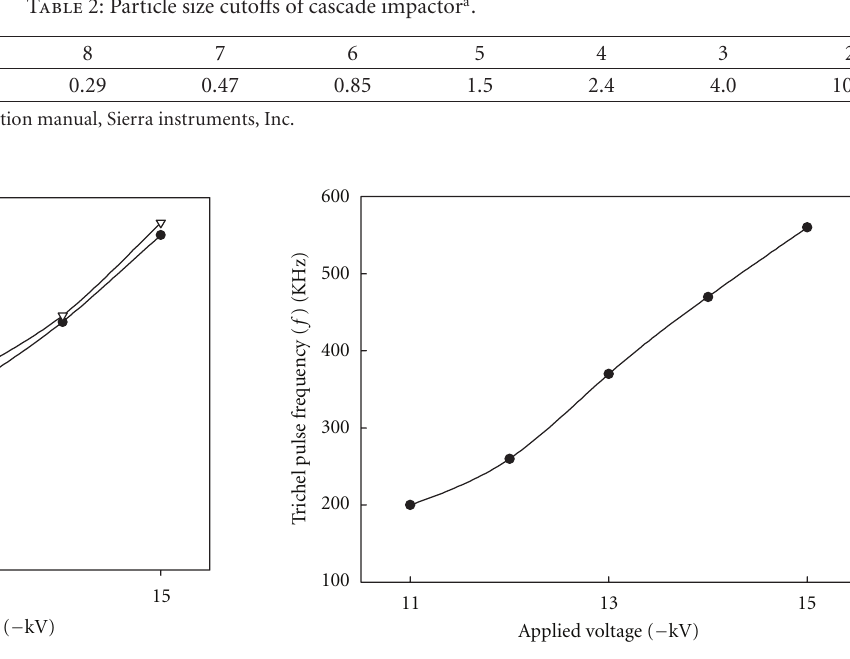
Figure 5: Trichel pulse frequency versus applied voltage in the wet